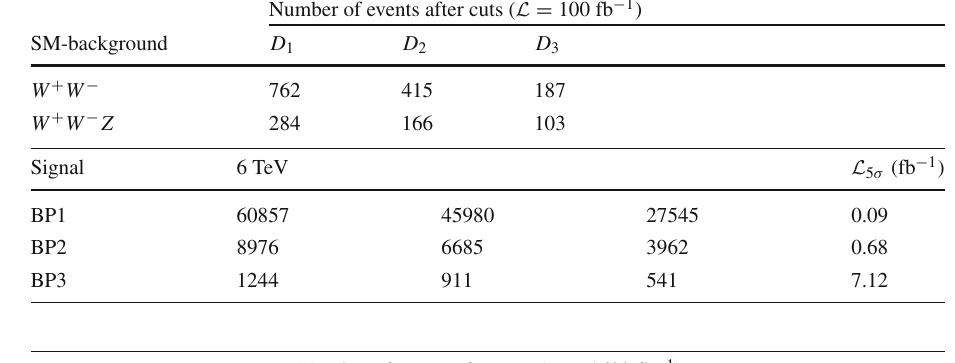
Table 8 The cut-flow for signal and backgrounds along with the required integrated luminosity to achieve 5 σ significance for the μ + μ − → 1 l + 2 j + E T / channel for BP4–BP8 at 14 TeV Muon